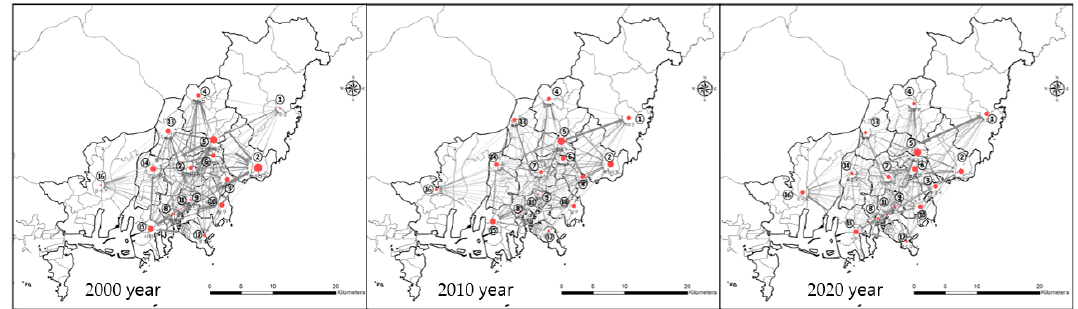
Figure 6. Social Network Analysis of migration in BMC. Note: The base map was adopted from the National Spatial Data Infrastructure Portal of Korea (www.nsdi.go.kr (accessed on 12 August 2022)). The results shown in Table 4 also support the movement patterns toward the outskirts. Among the areas located on these outskirts, Haeundae-gu, Gangseo-gu, and Geumjeong-gu demonstrated higher centrality for in-migration than for out-migration in 2000, 2010, and 2020, while Gijang-gun demonstrated higher in-migration than out- migration following 2010. The eigenvector centrality shown in Table 4 indicates the central influence of movement, considering both in-migration and out-migration. Haeundae-gu,